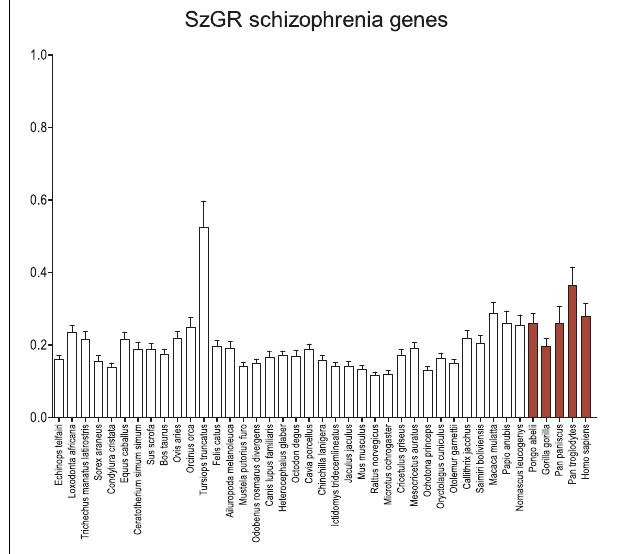
FIGURE 4 | Average d N /d S across taxa of SzGR schizophrenia- associated genes. Average d N /d S of genes positively associated with schizophrenia based on associations collected in the Schizophrenia Gene Resource (SzGR). Average d N /d S ratios suggest changes in selective regime in catarrhines and dophin similar to the GAD gene set. Pairwise significance values are shown in Supplemental Table